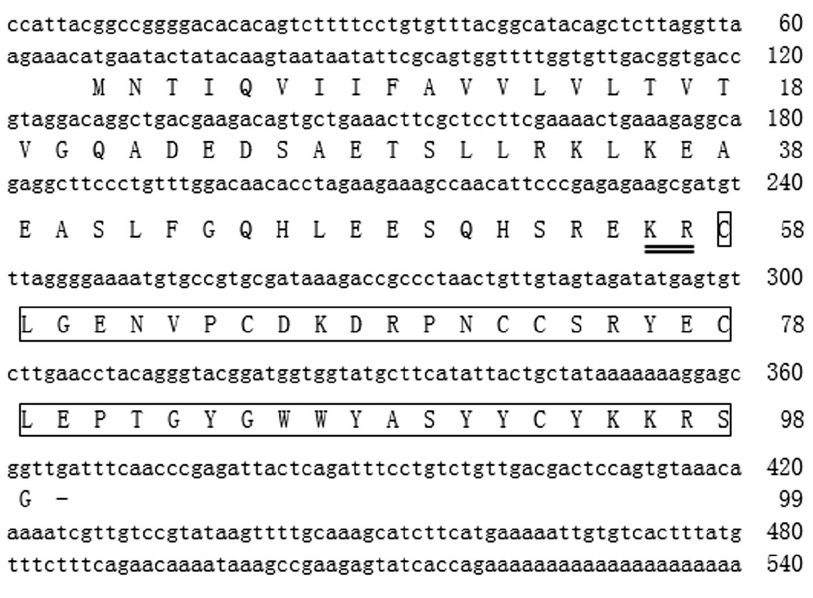
Figure 2. cDNA sequence encoding brachyin and deduced amino acid sequence. Mature peptides are boxed. The bar ( 2 ) indicates stop codon. The di-basic site for proprotein convertase processing is double lined.